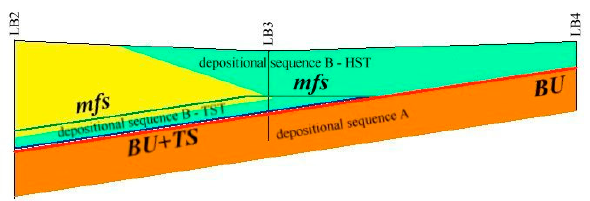
Figure 6. Sequence stratigraphy schematic setting. BU (red line): Basal Unconformity; TS (blue line): Transgressive Surface; mfs (green line): maximum flooding surface; TST: Transgressive System Tract; HST: High Stand System Tract. Depositional sequence A (brown) is constituted by coastal Pleistocene sediments. Depositional sequence B (TST + HST) is constituted by beach, bar and dune sediments (yellow) and lagoon/lacustrine sediments (light green).